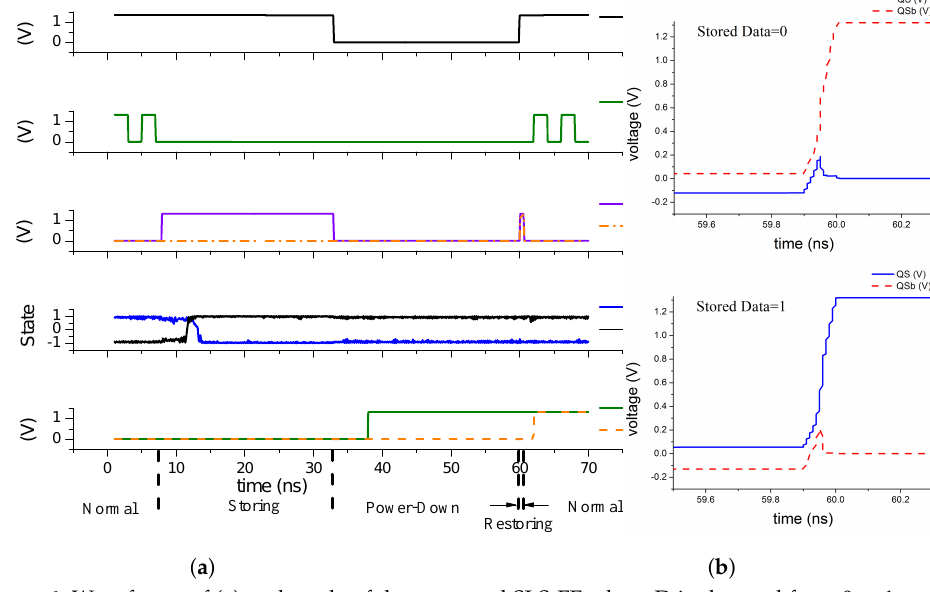
Figure 6. Waveforms of ( a ) each node of the proposed SLS-FF where D is changed from 0 to 1, and ( b ) QS and QSb for enlarged views. Y-axes indicate voltage (V) of VDD, CLK, SEN, REN, D and Q nodes or states of MTJs (mz_A—MTJ A ’s spin direction on Z axis, mz_B—MTJ B ’s spin direction on Z